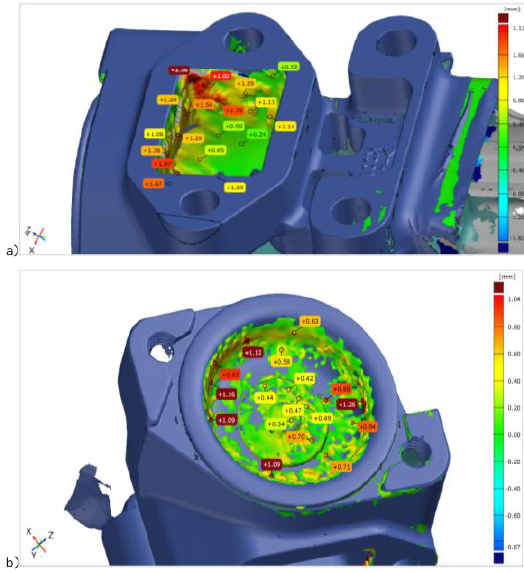
Fig. 10. Thickness of carbon deposits in an EGR valve chamber measured using optical scanning microscopy, a) on side of the valve stem, b) on side of the valve head